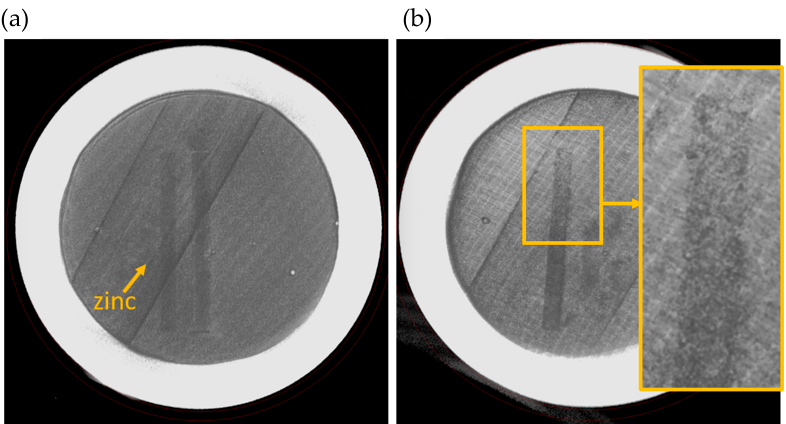
Figure 8. XCT images of AM tin melt wire. ( a ) Original XCT image of tin encapsulated in helium, and ( b ) post-furnace image of melted tin enhanced with color.